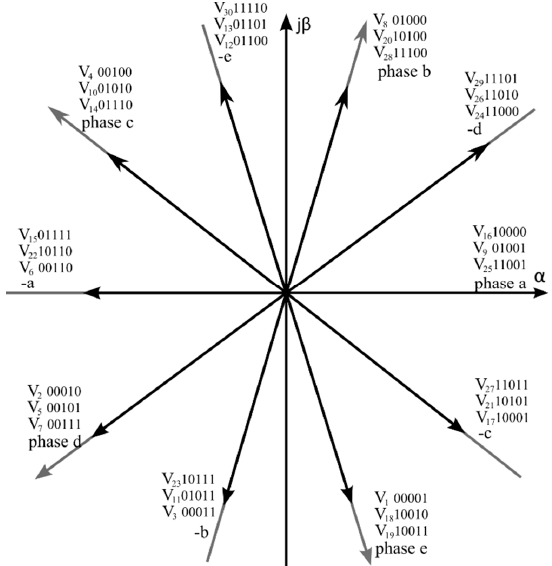
Figure 8. Polar voltage space vectors of the two-level five-phase VSI.